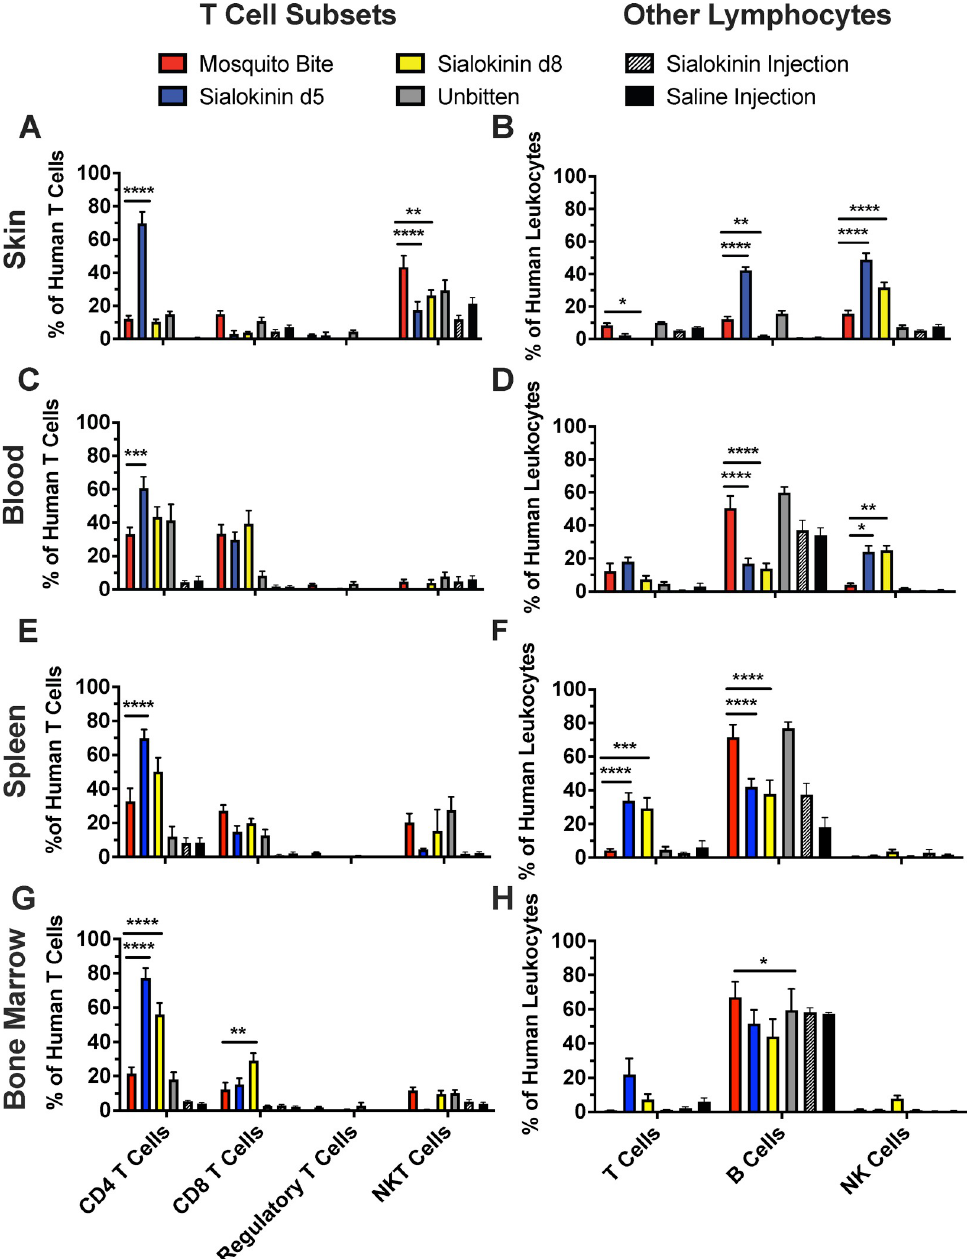
Fig 4. Sialokinin knockout mosquito bites induce CD4+ T cell and NK cell populations in humanized mice. Hu-NSG mice were subjected to four bites each from sialokinin knockout mosquitoes and were euthanized 7 days postbite. Skin, blood, spleen, and bone marrow were collected and changes in T cell ( A, C, E, G ) and other lymphocyte ( B, D, F, H ) populations were assessed via flow cytometry. Mosquito Bite indicates mice bitten by wild-type mosquitoes, and Unbitten indicates mice that were not bitten by mosquitoes. Data are represented as the mean percentage of the cell population out of total human T cell numbers or total human leukocytes. Regulatory T cell populations were not assessed in saline injection and sialokinin injection groups due to small percentages of CD4 T cells. Error bars represent 1 SEM. Statistical significance was determined using two-way ANOVA followed by multiple comparison t-tests using the Holm-Sidak correction. The threshold for significance was p < 0.05. Asterisks indicate: � = p < 0.05; �� = p < 0.01; ��� = p < 0.005; ���� = p < 0.001. Cell markers used to describe populations: CD4 T cells: CD45+, CD3+, CD4+, CD8-; CD8 T cells: CD45+, CD3 +, CD4-, CD8+; Regulatory T cells: CD45+, CD3+, CD4+, CD8-, FoxP3+; NKT Cells: CD45+, CD3+, CD56+; T cells: CD45+, CD3+; B cells: CD45+, CD3-, CD19+; NK Cells: CD45+, CD3-, CD56+. Abbreviations: NKT, Natural K T Cell; NK, Natural Killer Cell.